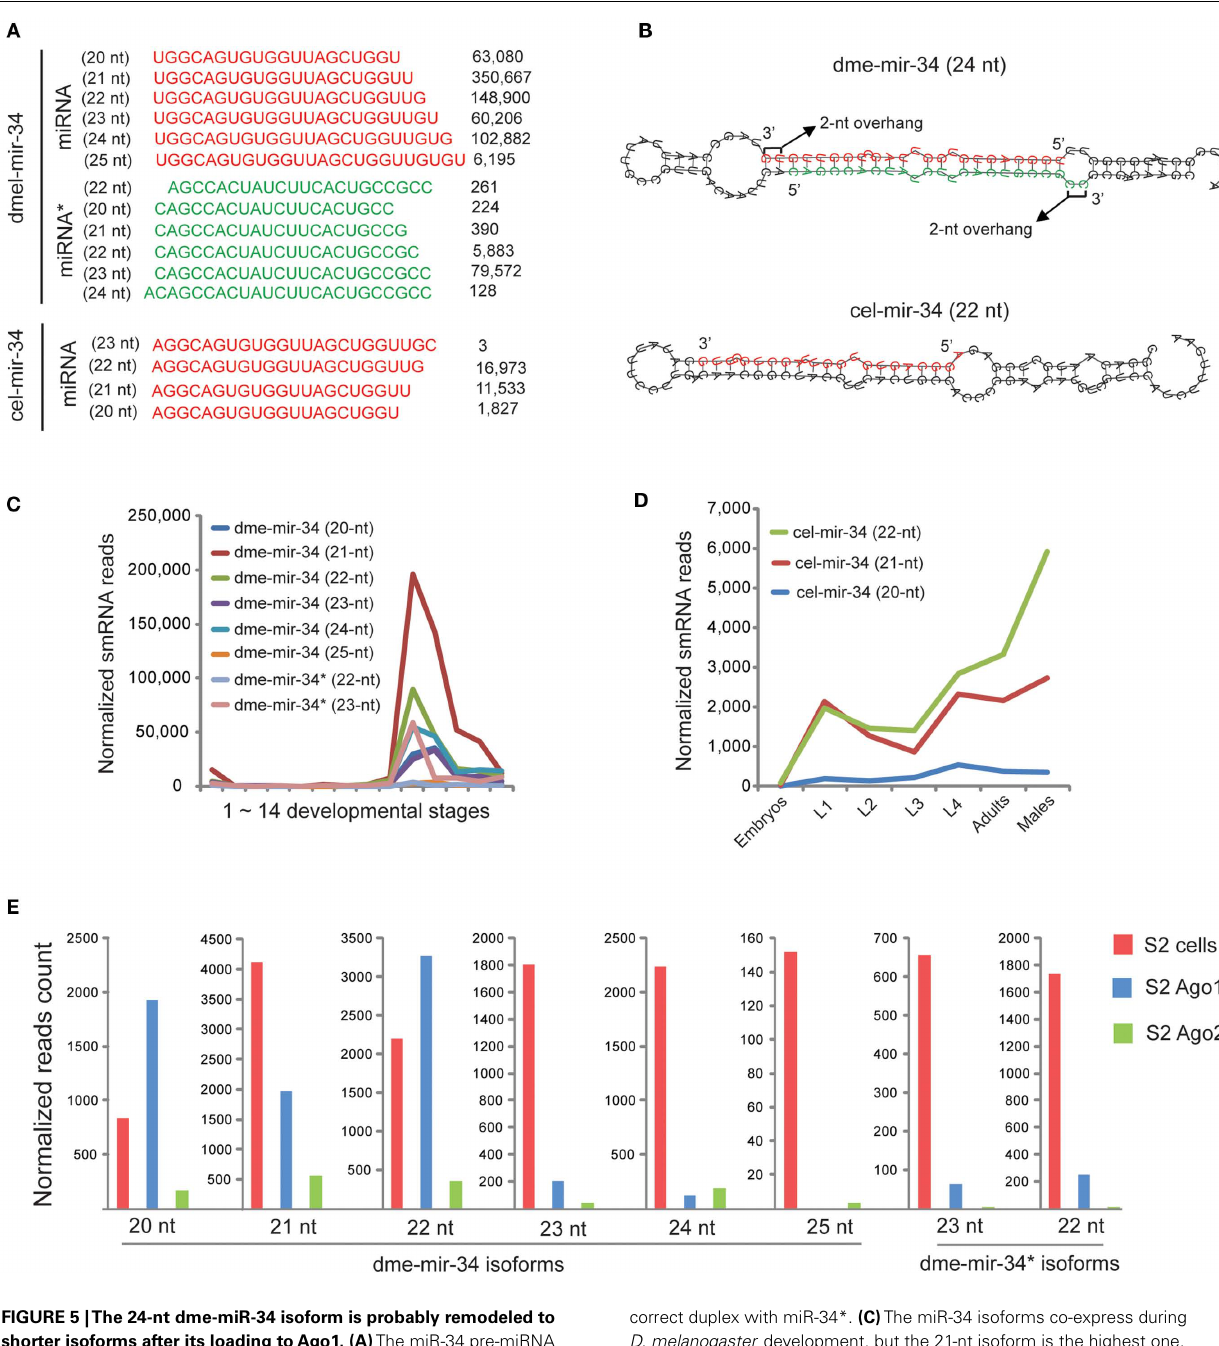
correct duplex with miR-34*. (C) The miR-34 isoforms co-express during D. melanogaster development, but the 21-nt isoform is the highest one. (D) The expression patterns of two miR-34 isoforms in C. elegans are not significantly different. (E) Only 20- to 22-nt dme-mir-34 isoforms are associated with Ago